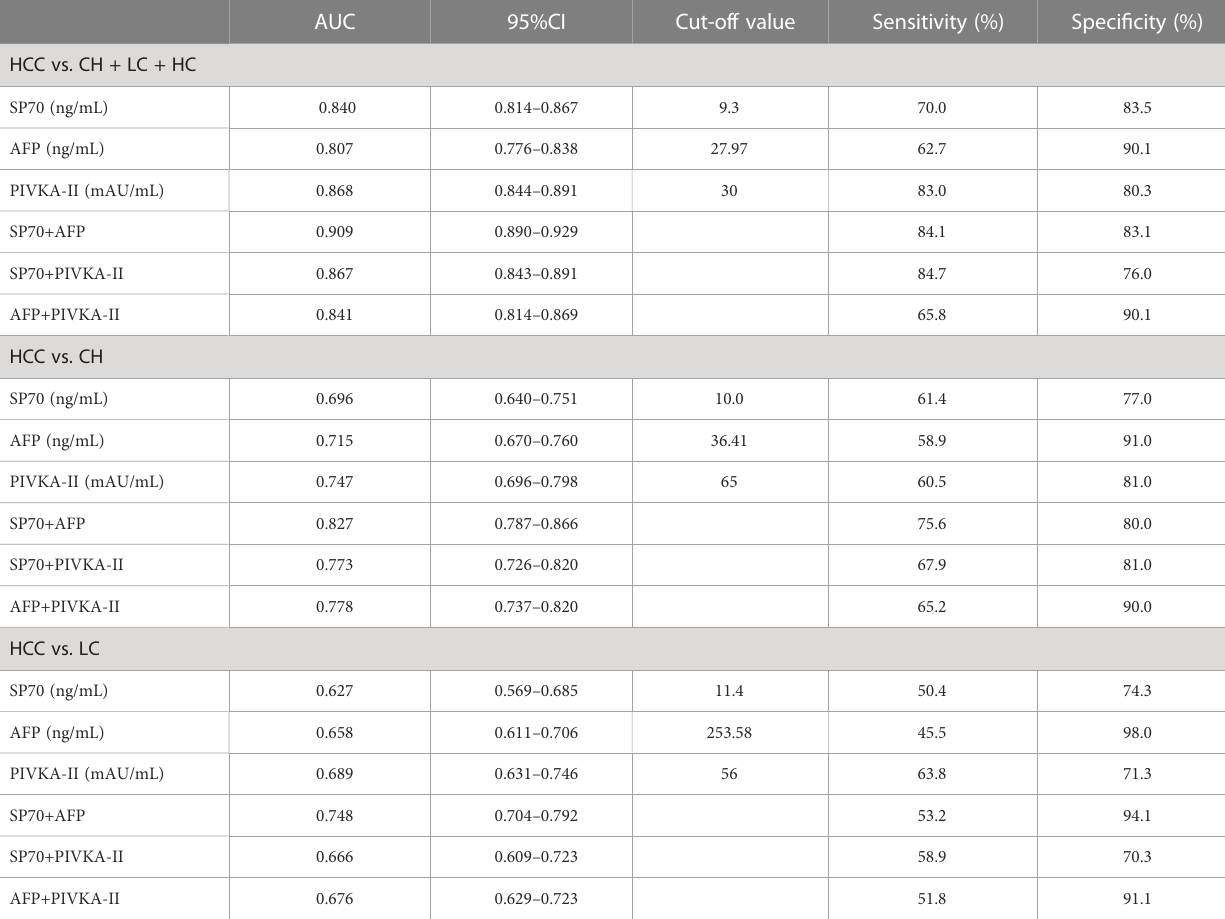
TABLE 2 Diagnostic performance of SP70, AFP, PIVKA-II and marker combinations in detecting